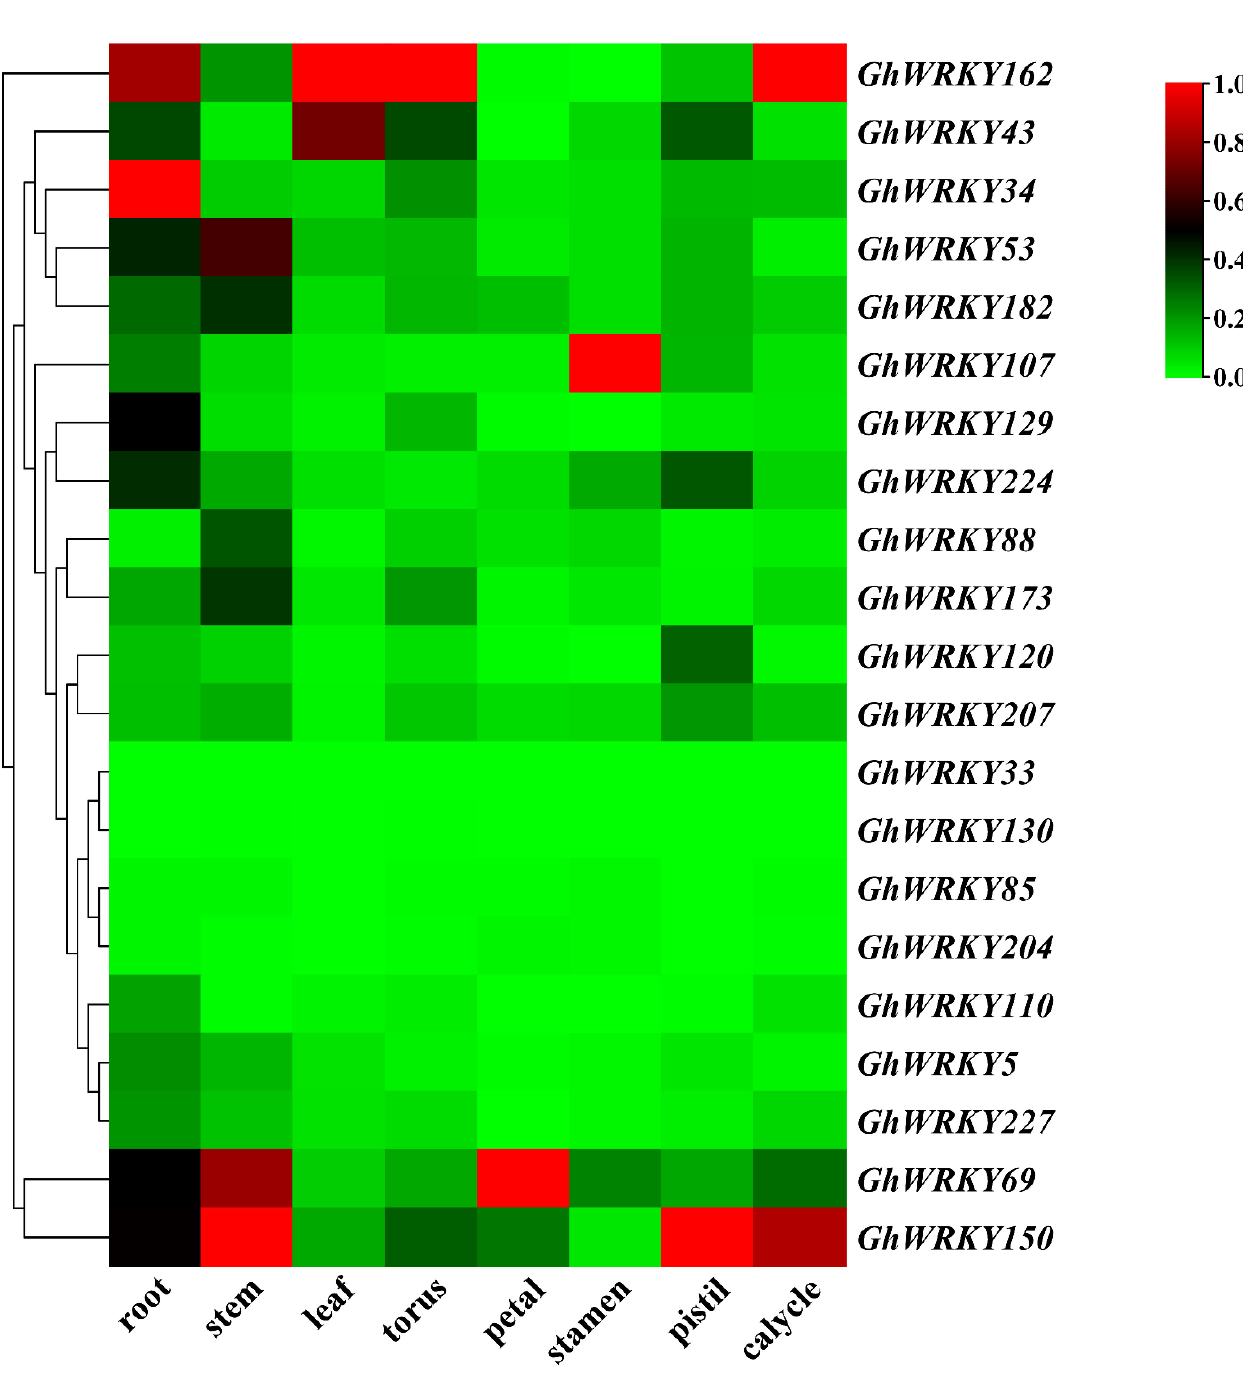
Figure 4. Expression profiles of group III WRKY genes in various tissues of G. hirsutum L . TM-1.